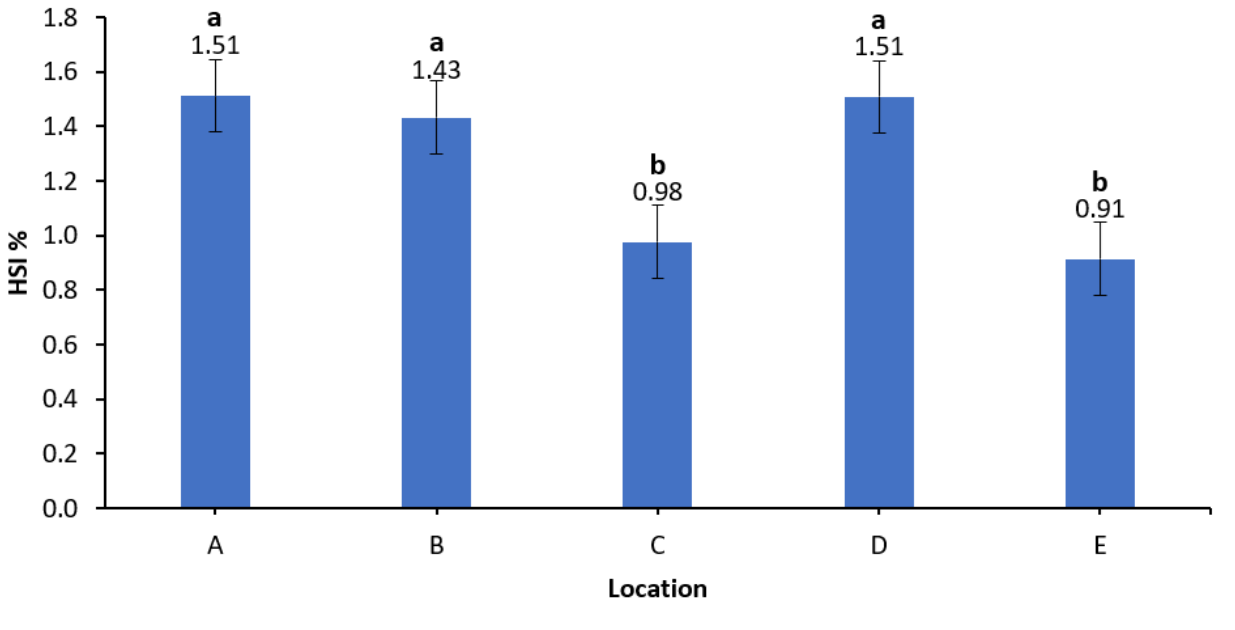
Figure 5. The average HSI values for each location ( n = 123). Different letters indicate significant difference between sampling locations (Tukey’s post hoc test, p < 0.05). Whiskers indicate ± SD.